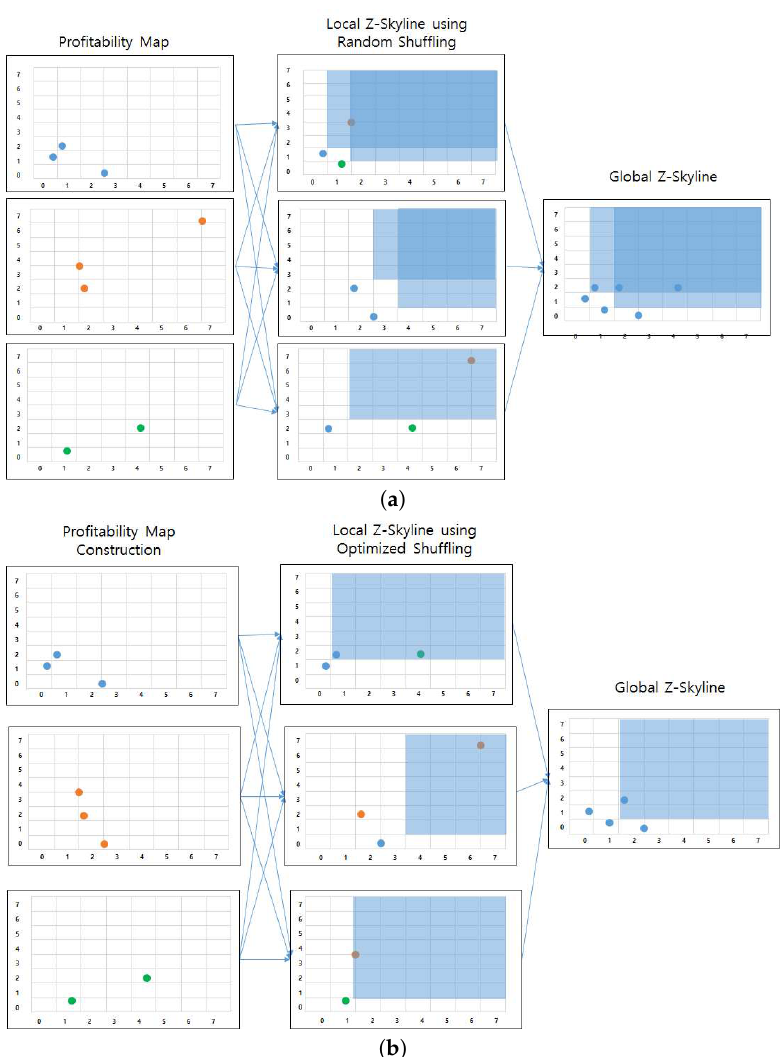
Figure 23. Data shuffling optimization. ( a ) Z-Skyline using random shuffling; ( b ) Z-Skyline using optimized